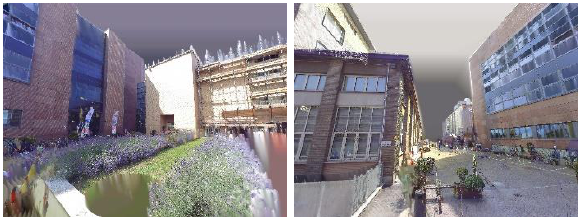
Figure 17 - Examples of the image